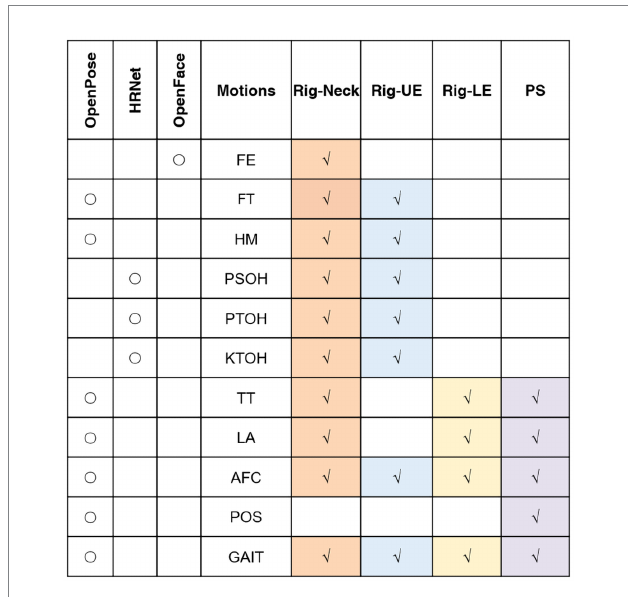
FIGURE 1 Relationships between movements, techniques and models. Rig, rigidity; UE, upper extremity; LE, lower extremity; PS, postural stability; AFC: arising from chair; FE, facial expression; FT, finger tapping; HM, hand movements; KTOH, kinetic tremor of the hands; LA, leg agility; POS, posture; PSOH, pronation/supination of the hands; PTOH, postural tremor of the hands; TT, toe tapping; AFC: arising from chair; and FE, facial